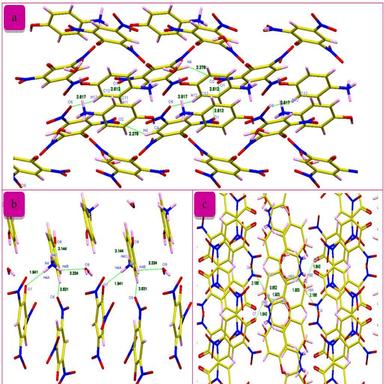
a) Crystal packing projection along a-axis with the C-H….O (b) b-axis with the N-H….O and (c) c-axis with the O-H….O interactions